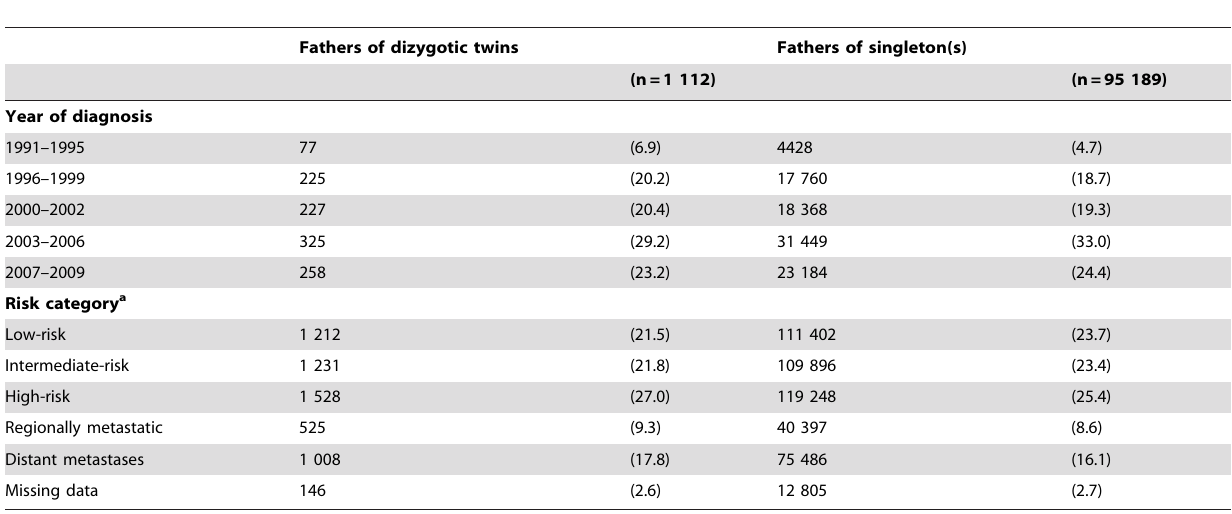
Table 3. Demographics and tumor characteristics of prostate cancer cases in Prostate Cancer database Sweden 2.0.